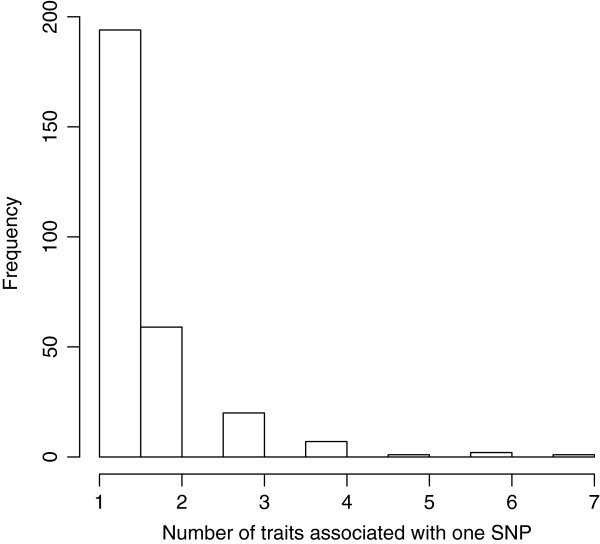
The number of SNP markers (y-axis) significantly associated to one or more traits (x-axis).